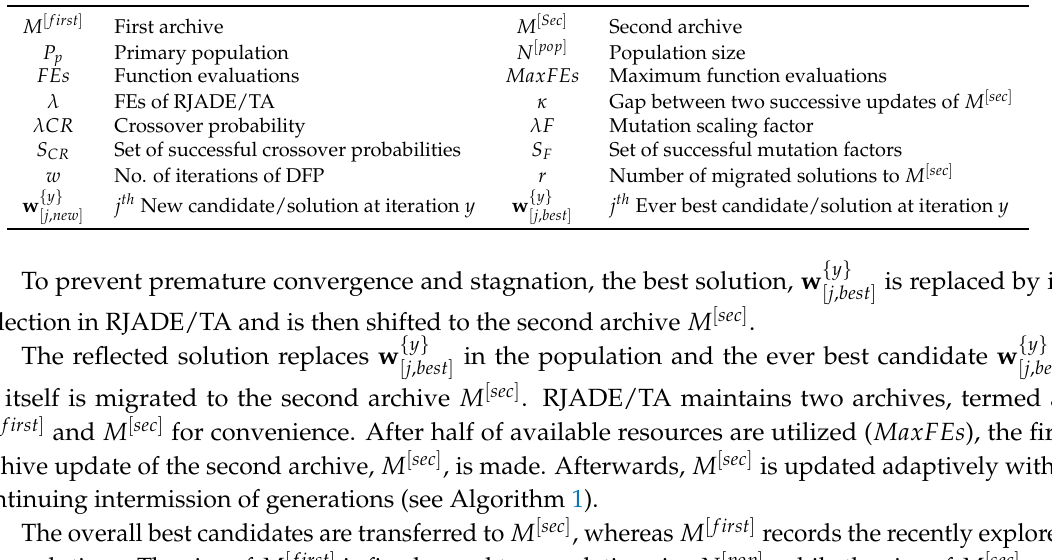
Table 1. Algorithmic